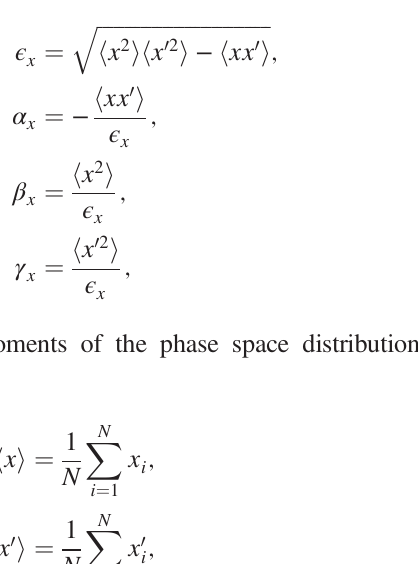
FIG. 42. The normalized phase space ð X; X 0 Þ ¼ ffiffiffiffiffiffiffiffiffi ffiffiffiffiffiffiffiffiffi p p β ϵ ϵ β ; ð α x þ β x 0 Þ = ð x= Þ for beam charge values x x x x x x 0 . 25 , 0.5 and 1 nC at a beam offsets of C Q b ¼ after traveling through 24 rf structures. The normalized coor- dinates transform the phase space ellipse to the unit circle. Also plotted is the RMS beam width σ (solid black), 3 σ x black), and 5 σ (dot-dashed x